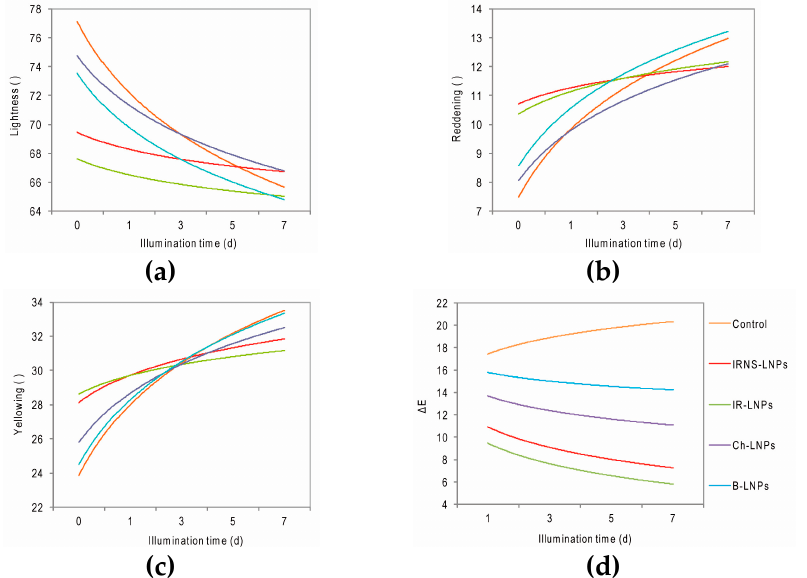
Figure 8. (a) Lightness; (b) Green-Red (Reddening); (c) Blue-Yellow (Yellowing) and (d) overall color difference ∆ E over the treatment time of artificial weathering for the uncoated beech wood samples (control) and those coated by LNPs from beech (B-LNPs), chestnut (Ch-LNPs), Iroko (IR-LNPs) and Iroko–Norway spruce (IRNS-LNPs) in the accelerated weathering